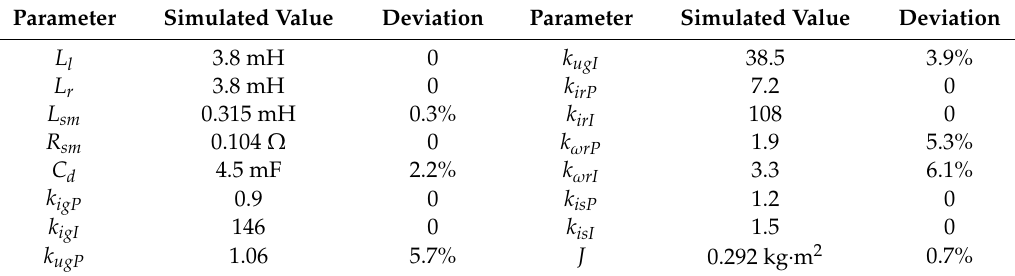
Table 5. The values of parameters for the critical stability case.